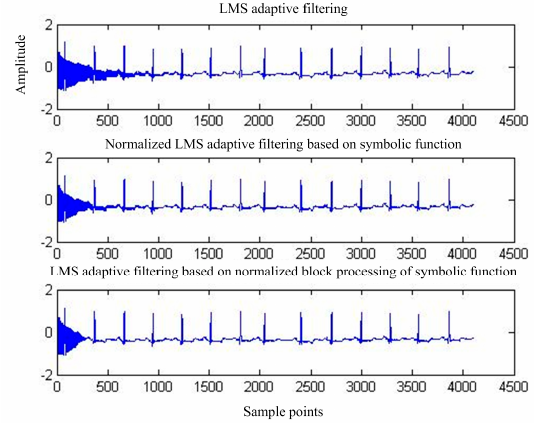
Figure 7. Output of the three adaptive interference cancellation algorithms.